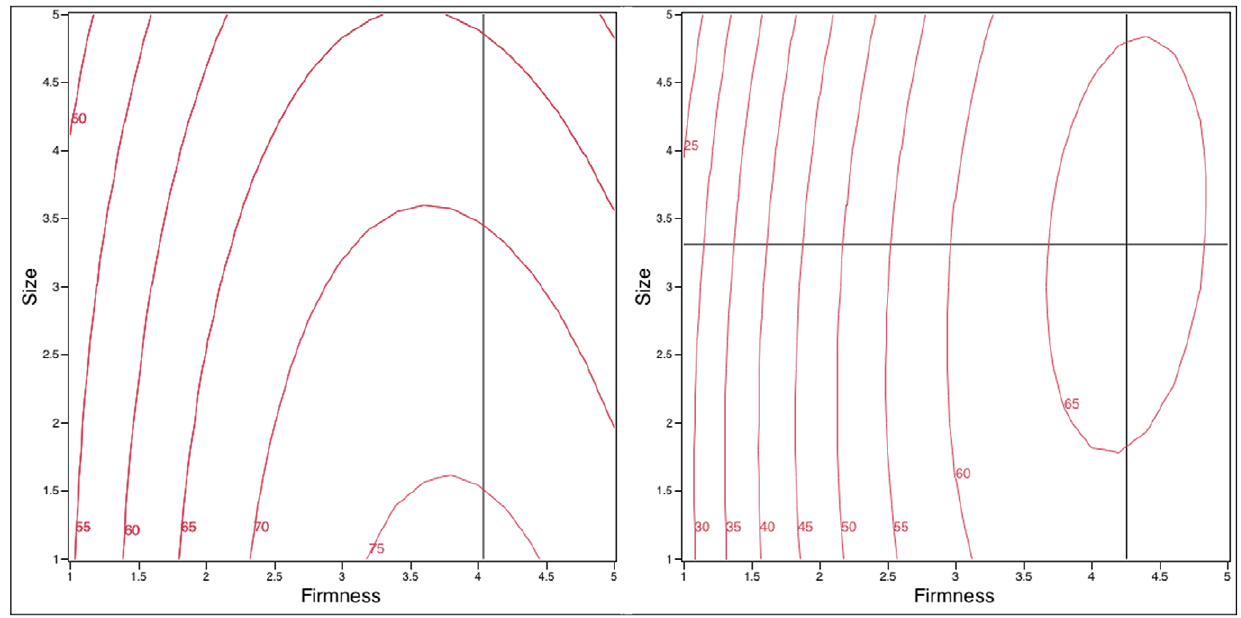
Figure 3. Contour plots of insertion ratings (0–100) as a function of design variables (Firmness and Size) in the with-Applicator (left) and without-Applicator groups (right). The cross hairs indicate the location of the maximum value; the optimal size for the with-applicator group was below 1 (outside the design space) and is not shown. A shaded region is not shown given the large differences in maximal values. doi:10.1371/journal.pone.0054975.g003 maximum, willingness declined as Firmness increased. The largest For the without-applicator group (Figure 4, right), the RSM effect of Size was seen near optimum Firmness (right side of left plot model was significant (F 5,3 = 23.24, p= 0.0132), explaining of in Figure 3): as Size increased, willingness declined. An maximal 97.4% of the variation in mean willingness . The interaction of willingness value was observed near Firmness=3.39; again, the Firmness by Size (F 1,3 = 0.09, p = 0.776) was not significant. optimal size fell outside the design space (below 1 g). Regarding Firmness, both the linear (F 1,3 =88.37, p = 0.0026)